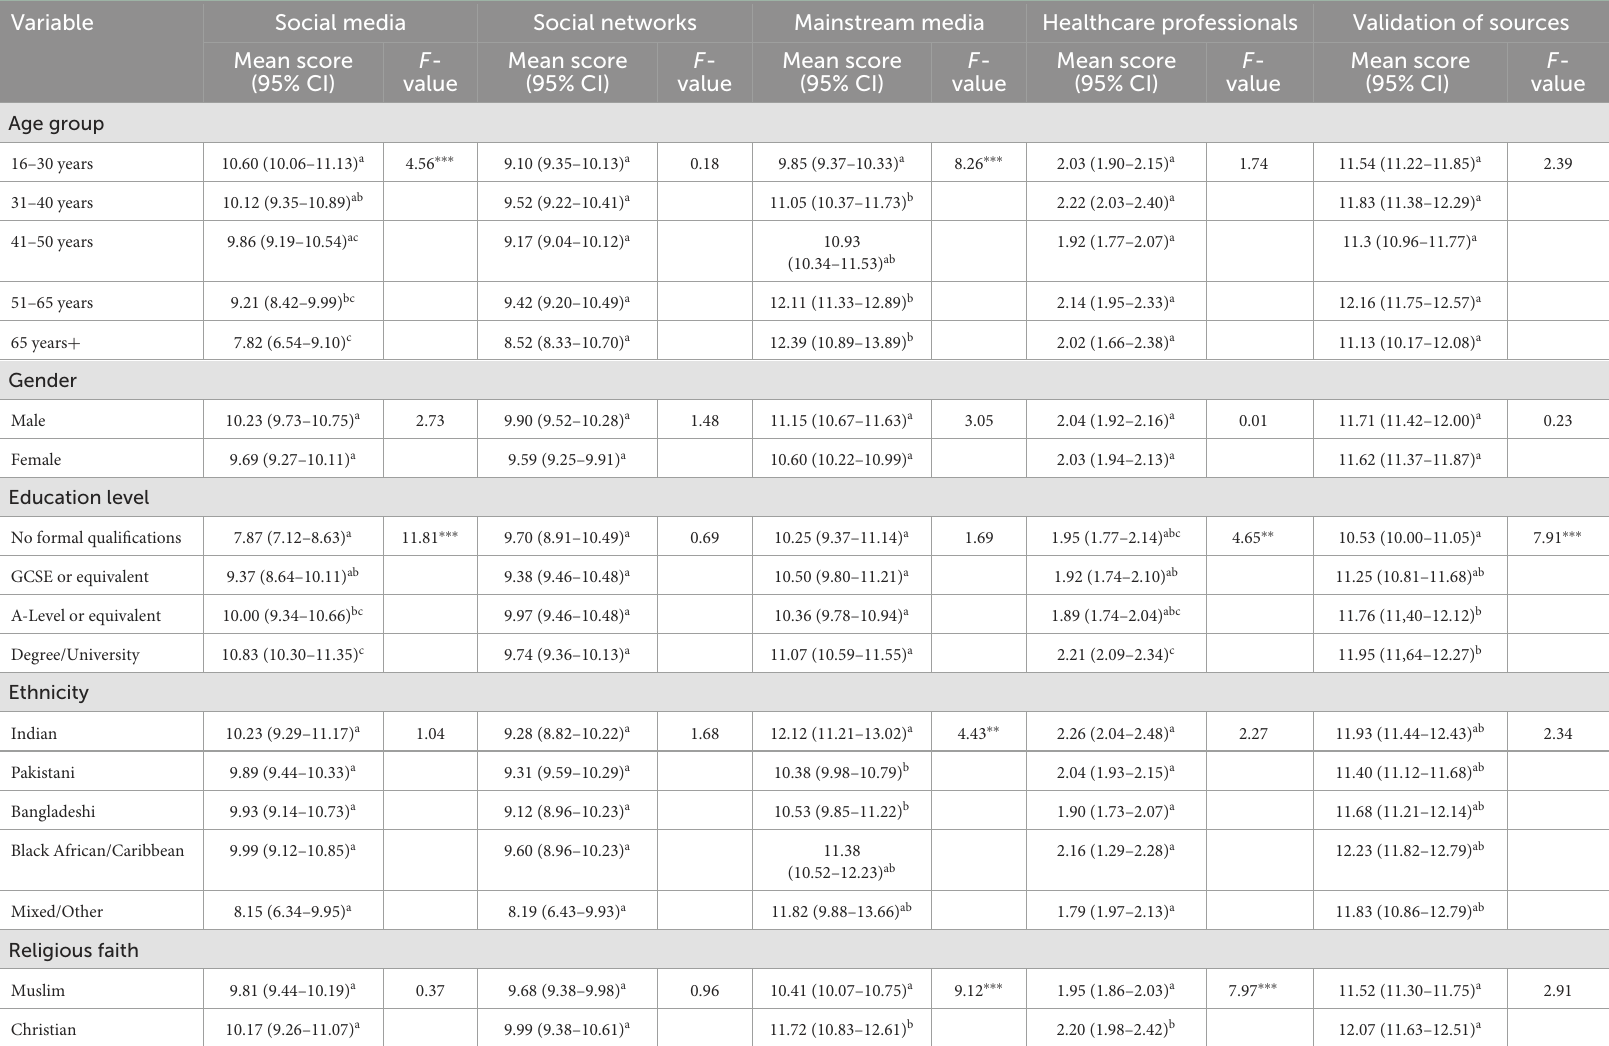
TABLE 4 Univariate Analyses of Variance (ANOVAs) of study variables by socio-demographic and information seeking